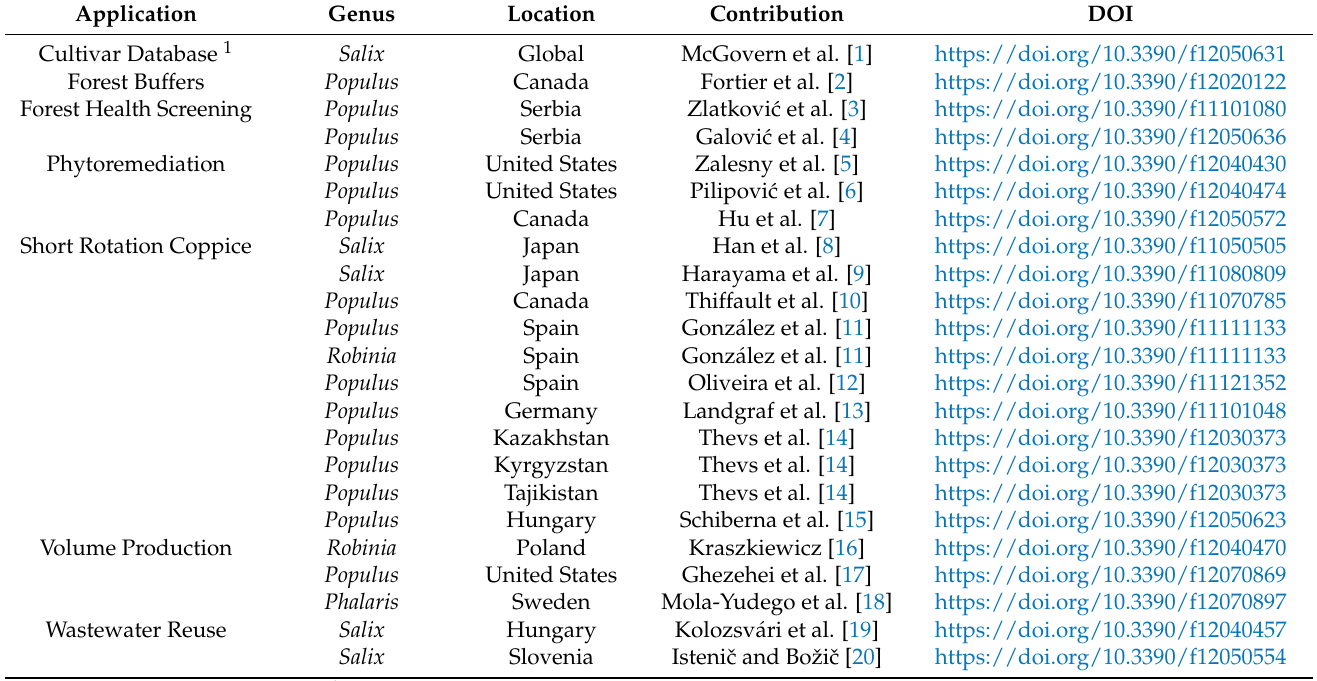
Table 1. Applications of short-rotation woody crops tested worldwide and described in the contri- butions of the Special Issue on the Growth and Development of Short-Rotation Woody Crops for Rural and Urban Applications (https://www.mdpi.com/journal/forests/special_issues/growth_ development_woody_crops; accessed on 25 May